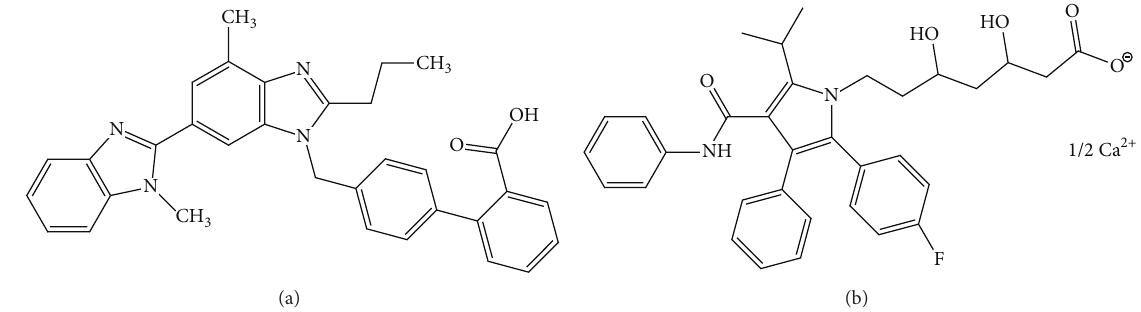
Figure 1: The chemical structure of (a) Telmisartan and (b) Atorvastatin calcium.